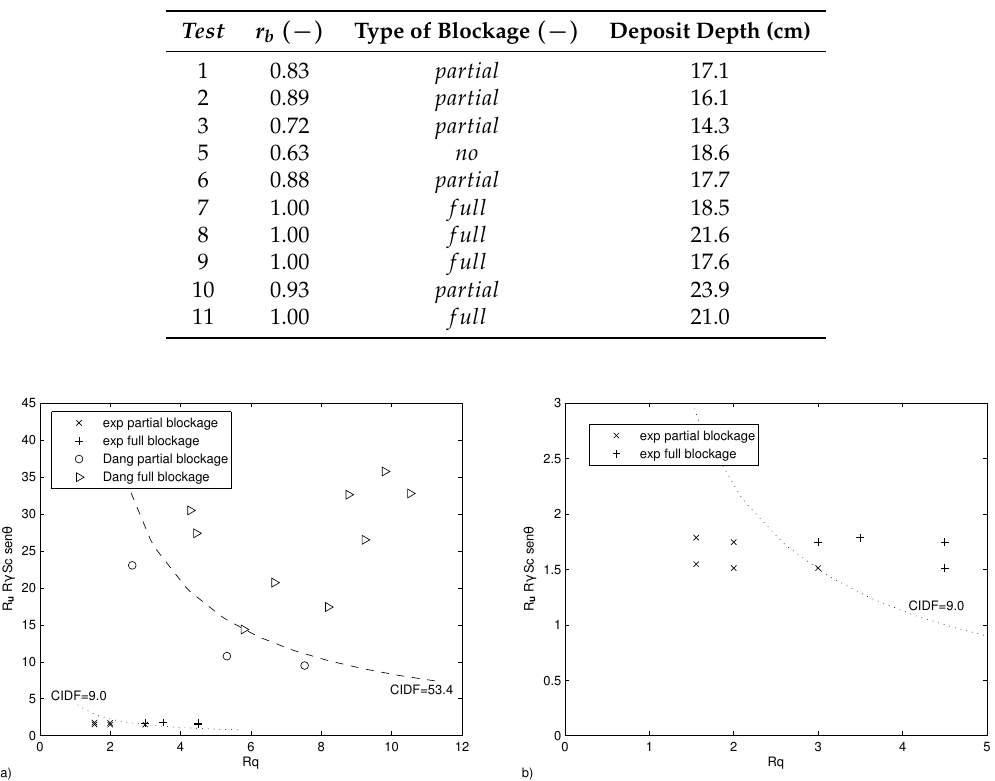
Table 3. Summary of the channel obstruction configurations and the maximum deposit depth observed in the present flume tests. The varying quantities related to the obstruction are defined as follows. r b : obstruction ratio of the maximum extension of the deposit along a direction orthogonal to the main river flow and to the main river width.